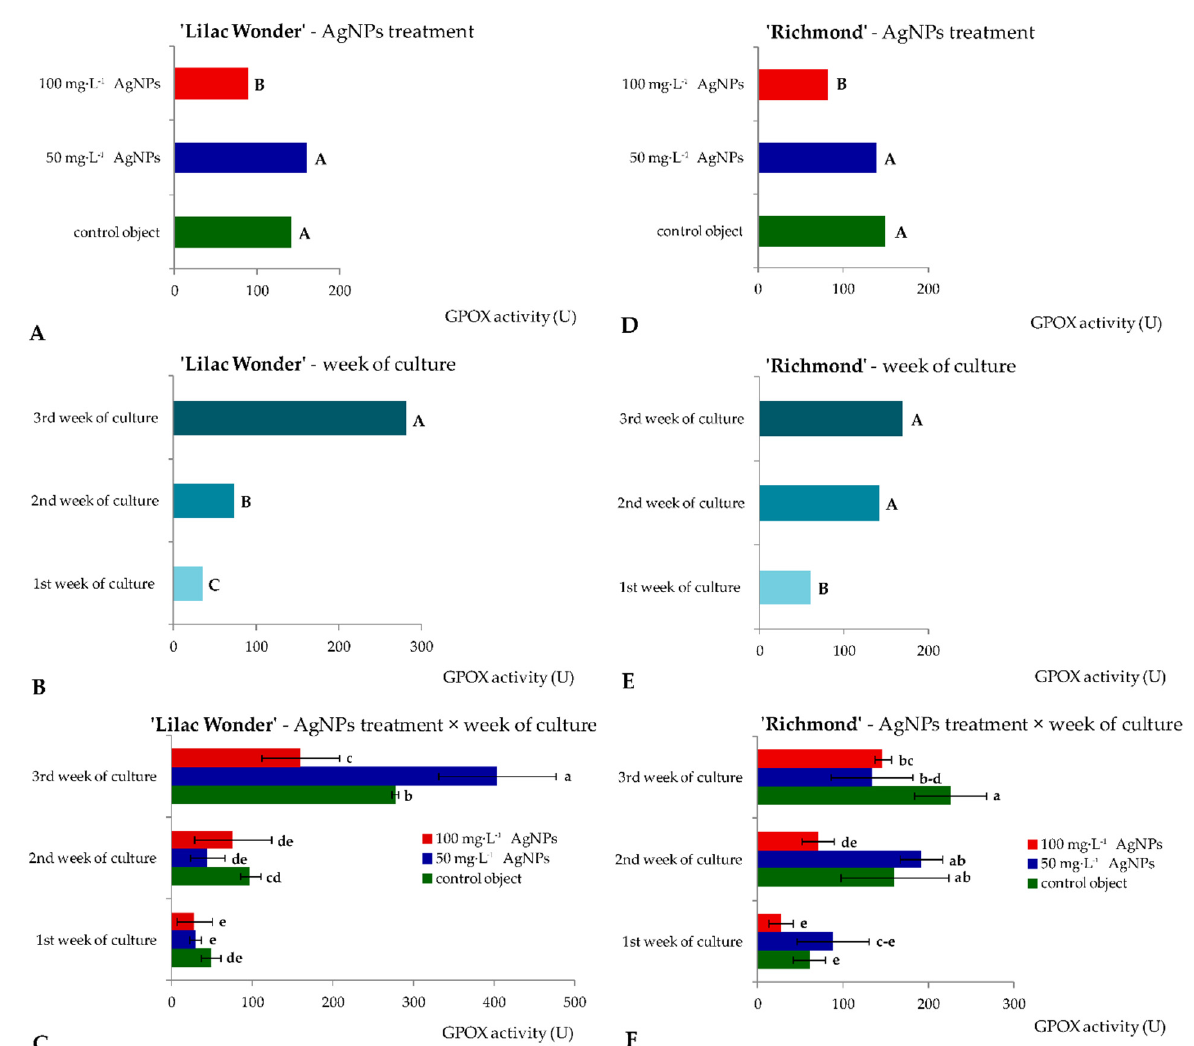
Figure 5. Activity of guaiacol peroxidase in Chrysanthemum × grandiflorum ‘Lilac Wonder’ (graphs A – C ) and ‘Richmond’ (graphs D – F ) leaf explants cultured in vitro on the modified MS medium with 0.6 mg·L − 1 BAP and 2 mg·L − 1 IAA, depending on the AgNPs treatment (0–100 mg·L − 1 ) and week of culture (first–third). Means and means ± SD on graphs for each cultivar tested followed by the same letter do not differ significantly at p ≤ 0.05 (Tukey’s test). Upper-case letters refer to the main effects (irrespectively) (graphs A , B , D , F ), lower-case letters refer to the interaction between the